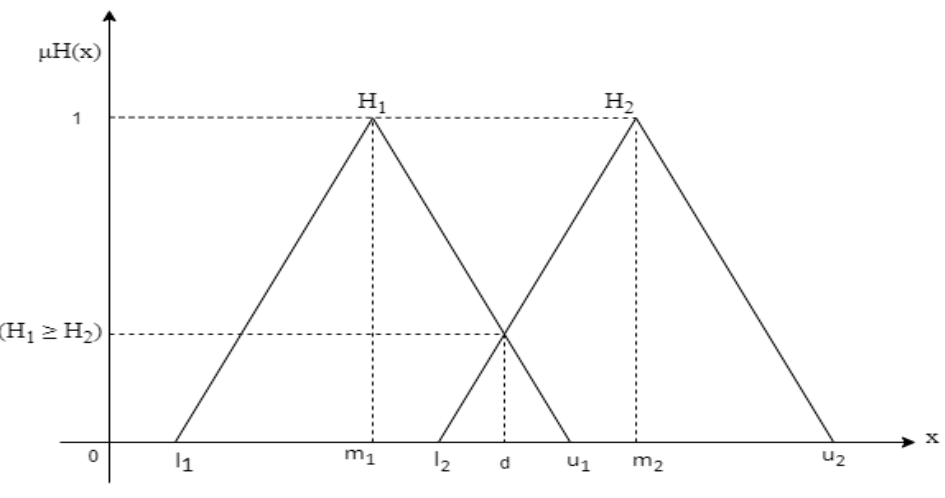
Figure 2. Degree of the possibility of two TFN.